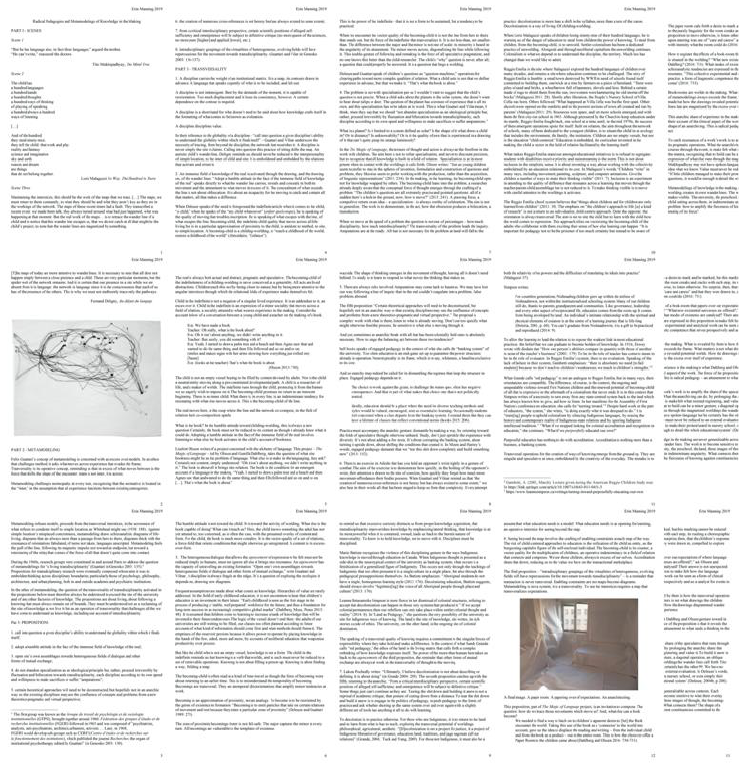
Figure 3 : File of Manning’s text saved in its entirety a ‘ whole ’ in a pdf